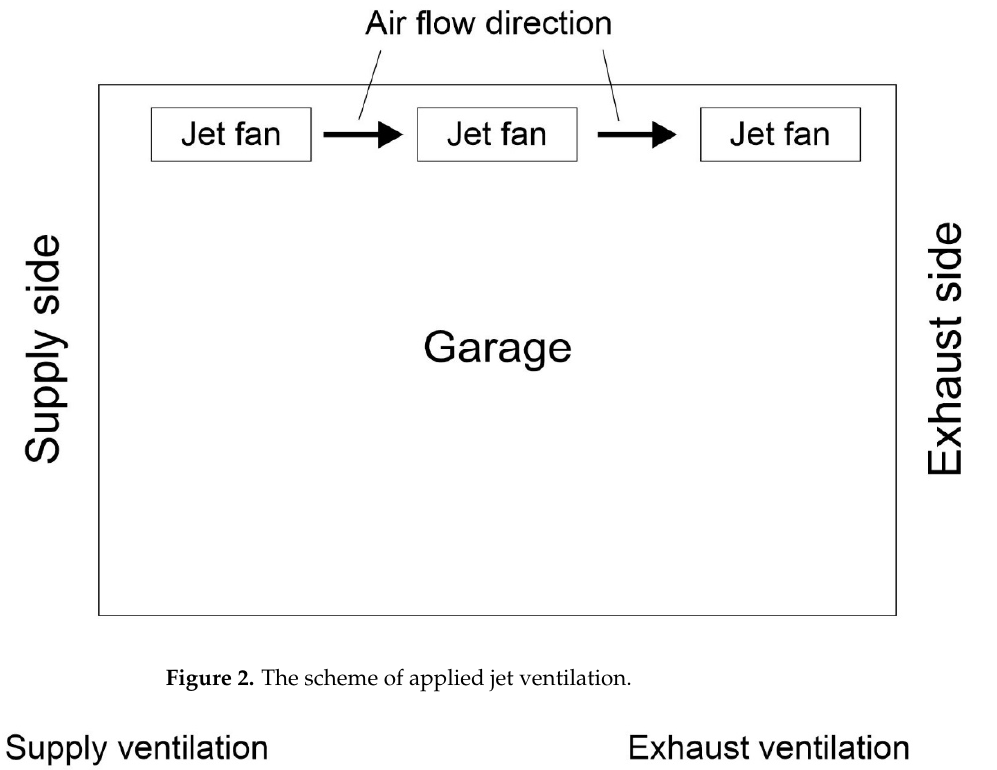
Figure 2. The scheme of applied jet ventilation.